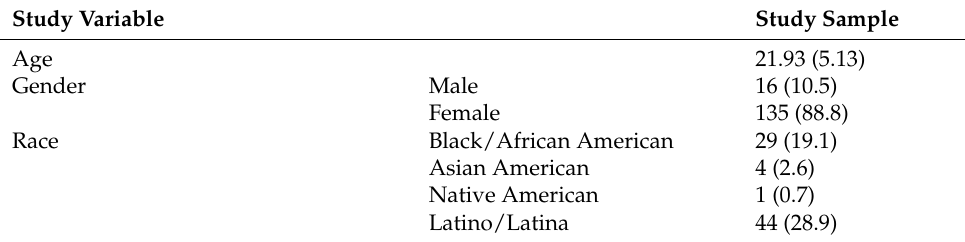
Table 1. Descriptive statistics for study sample ( N =